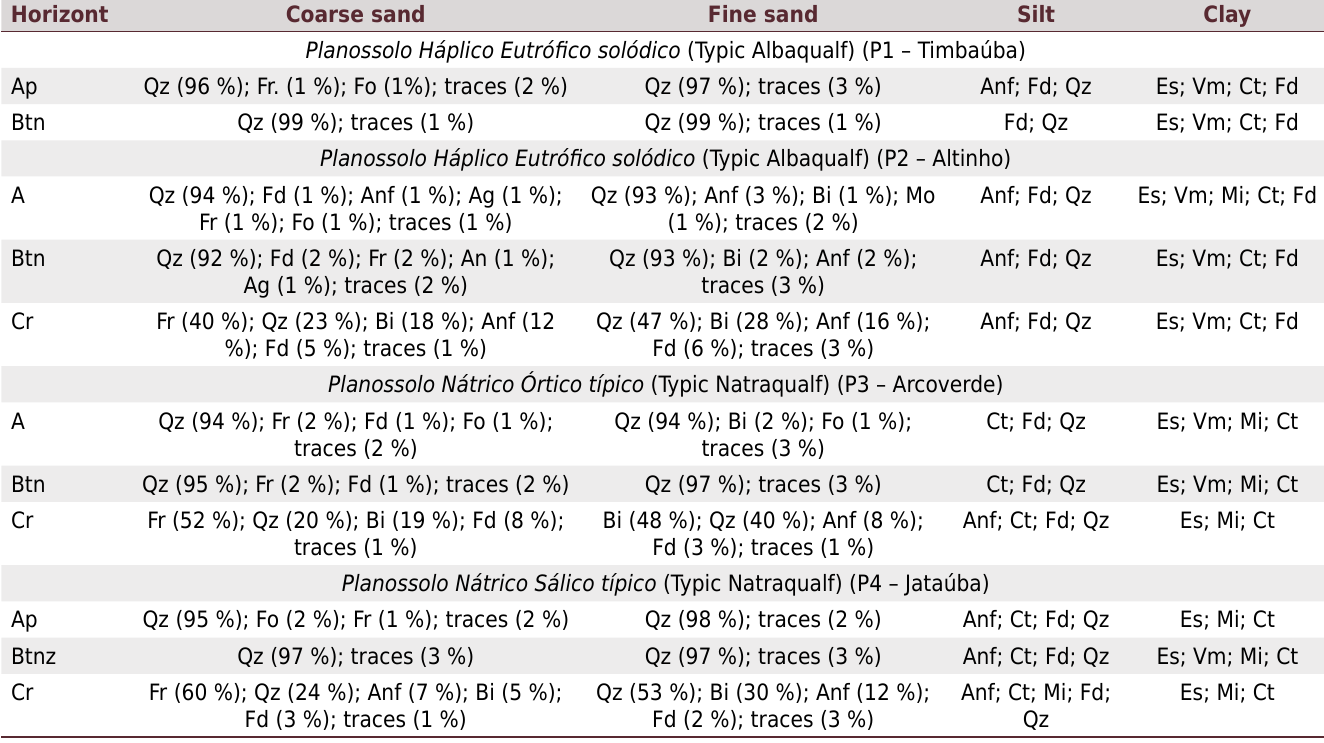
Table 4. Mineralogical composition of the fractions coarse sand, fine sand (qualitative and quantitative), silt and clay (qualitative) of soils studied